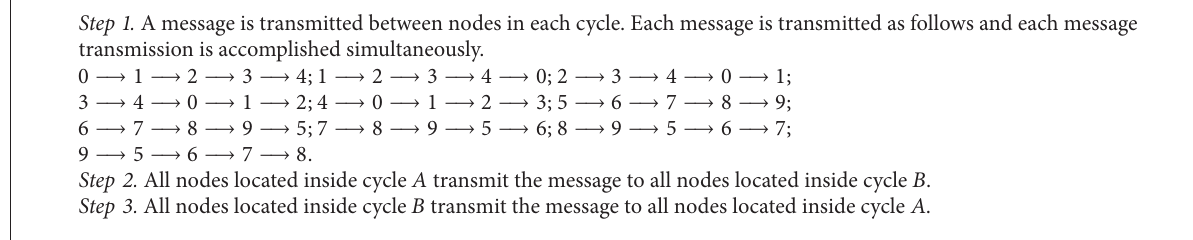
Algorithm 2: All-to-all broadcasting algorithm of Petersen graph under SLA model.